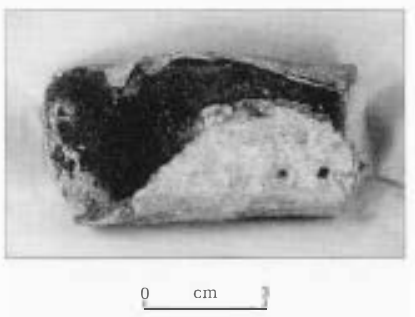
Figure 3 One of the horn tubes contain­ ing human hair, photographed after clean­ ing but before conservation at the Institute of Archaeology.